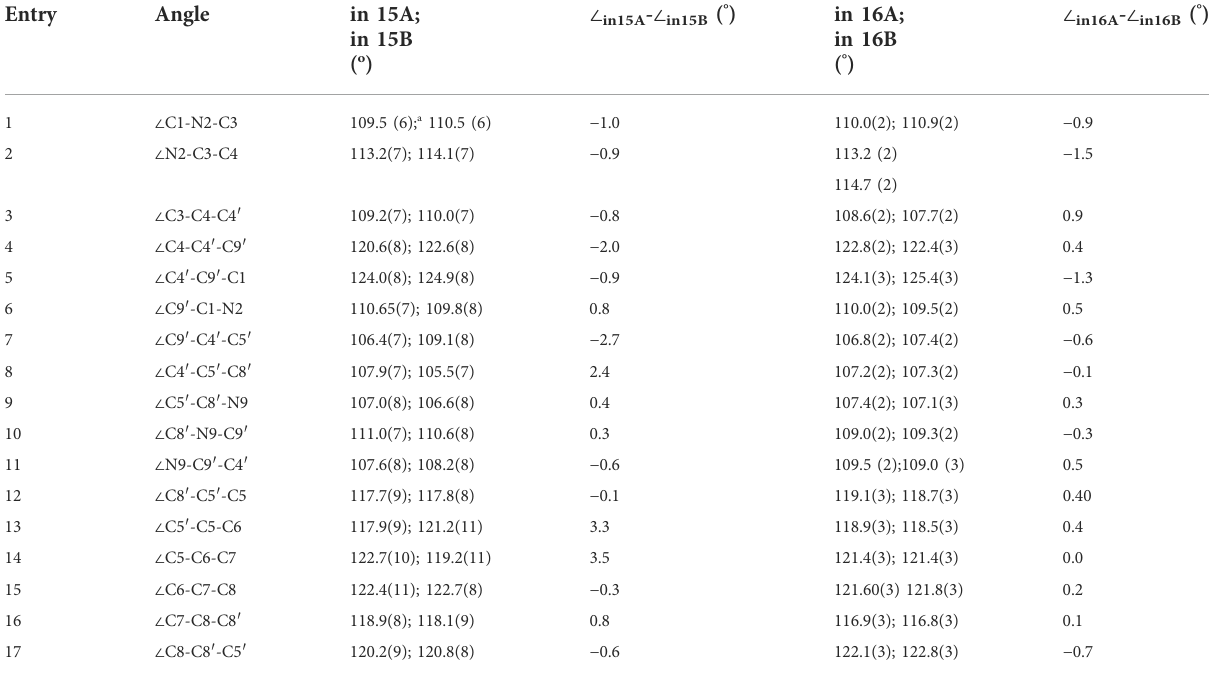
solid state NMR and IR results were found for 16 (Figure 6 and Table 1) and 15 . The corresponding angles within 15A and 15B also had different sizes as seen in their in X-ray structures. One example is the C1-N2-C3 angle, which is 109.5 ° in 15A vs. 110.5 ° in 15B . All